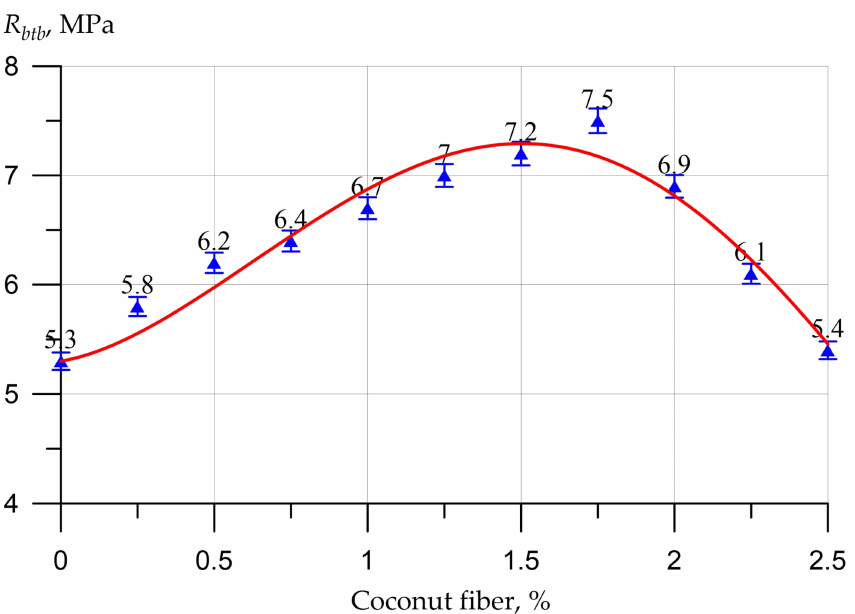
Figure 9. Dependence of tensile strength in bending ( R btb ) of prism concrete samples with dimensions of 100 × 100 × 400 (mm) on the percentage of coconut fibers.